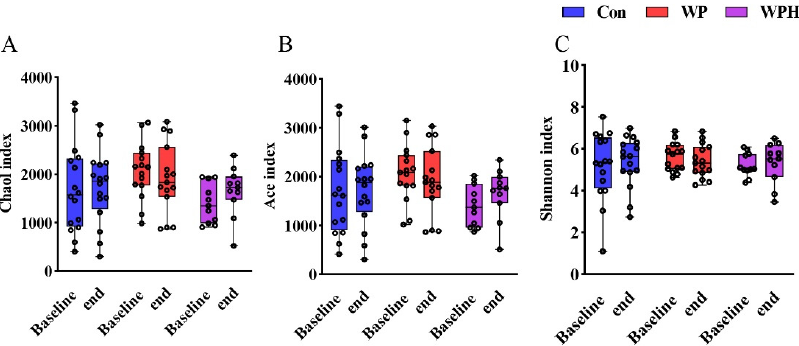
Figure 2. Serum metabolomics changed after the intervention. PCoA ( A ) and OPLS-DA score plots ( B ) comparing the serum metabolites before and after the intervention in each group. Changes in metabolic compounds in each group ( C ). * p < 0.05, ** p < 0.01. In the α diversity analysis, no significant change was observed after intervention among the three groups based on Chao1, Ace, and Shannon (Figure 3). No significant changes in gut microbiota composition were observed at the phylum, the family, and the genus levels when compared among the three groups. At the phylum level, Bacteroidetes and Firmicutes were dominant in human intestinal bacteria. In the control group, Bac- teroidetes were significantly decreased and Firmicutes were significantly increased com- pared with baseline. No significant differences were observed in the ratio of Bacteroidetes and Firmicutes (B/F) between baseline and end of intervention among the three groups (Figure 4A). At the family level, the percentage of Bifidobacteriaceae, Lachnospiraceae, Streptococcaceae, and Veillonellaceae was significantly increased compared with the baseline in the control group. WP intervention significantly increased the percentage of Lachnospiraceae and Clostridiaceae (Figure 4B). At the genus level, the percentage of Bifidobacterium, Lachnospira, and Streptococcus was significantly increased compared with baseline in the control group. WP intervention significantly increased the percentage of Bifidobacterium and Phascolarctobacterium (Figure 4C). Bacteria with significant dif- ferences among the three groups were not found via SEfSe analysis.